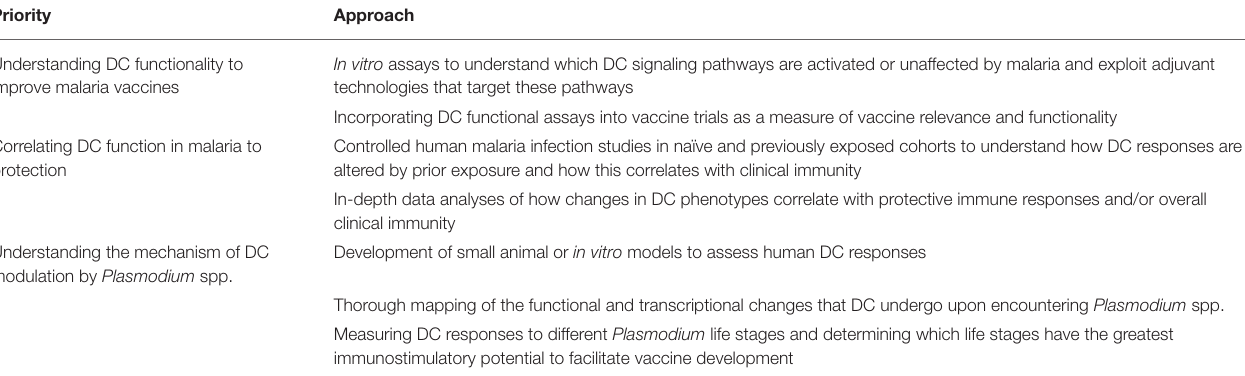
TABLE 3 | Research priorities in DCs and malaria.